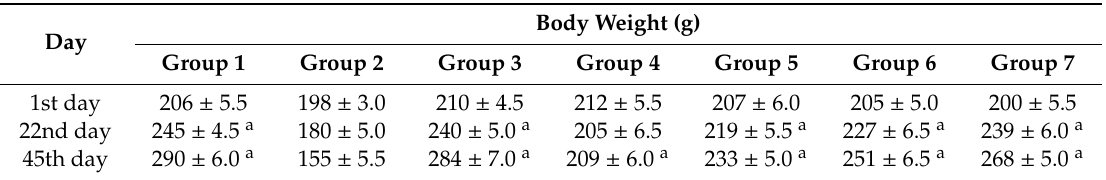
Table 2. E ff ect of the methanolic extract of Punica granatum leaves (100, 200, 400, and 600 mg / kg;